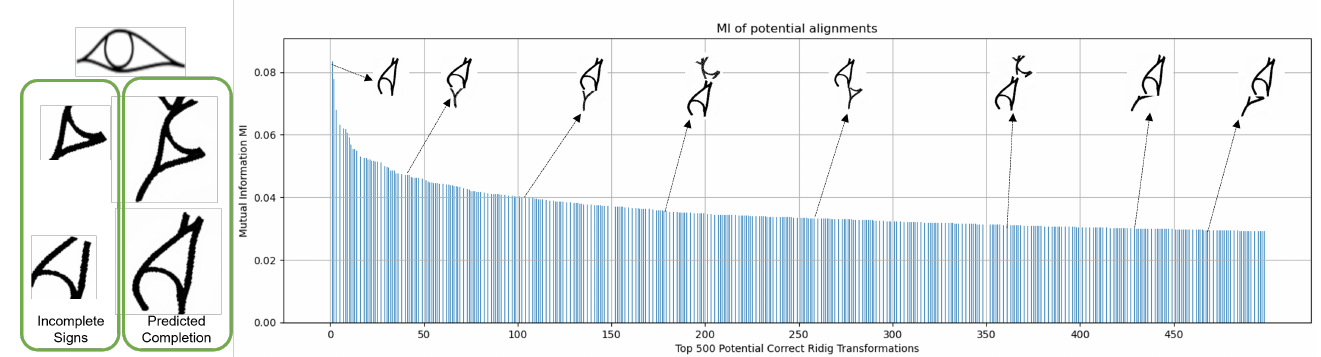
Figure 13. Example of the top 500 potential signs alignments based on MI for the eye sign. The Y -axis is the MI value, and the X -axis corresponds to the respective alignment